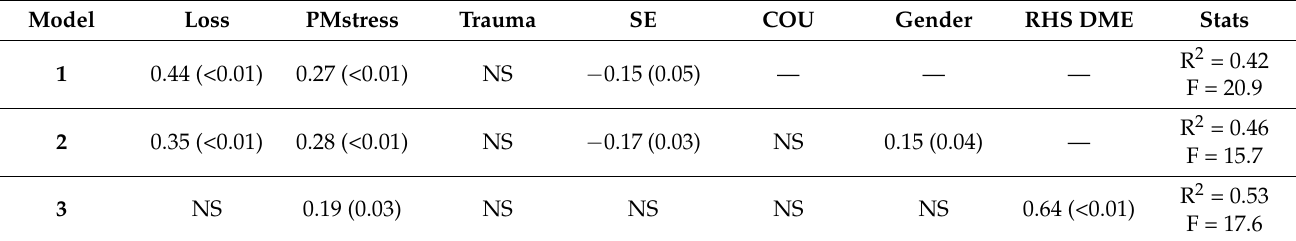
Table 6. Three regression models of predictor variables on trajectory, β , ( p